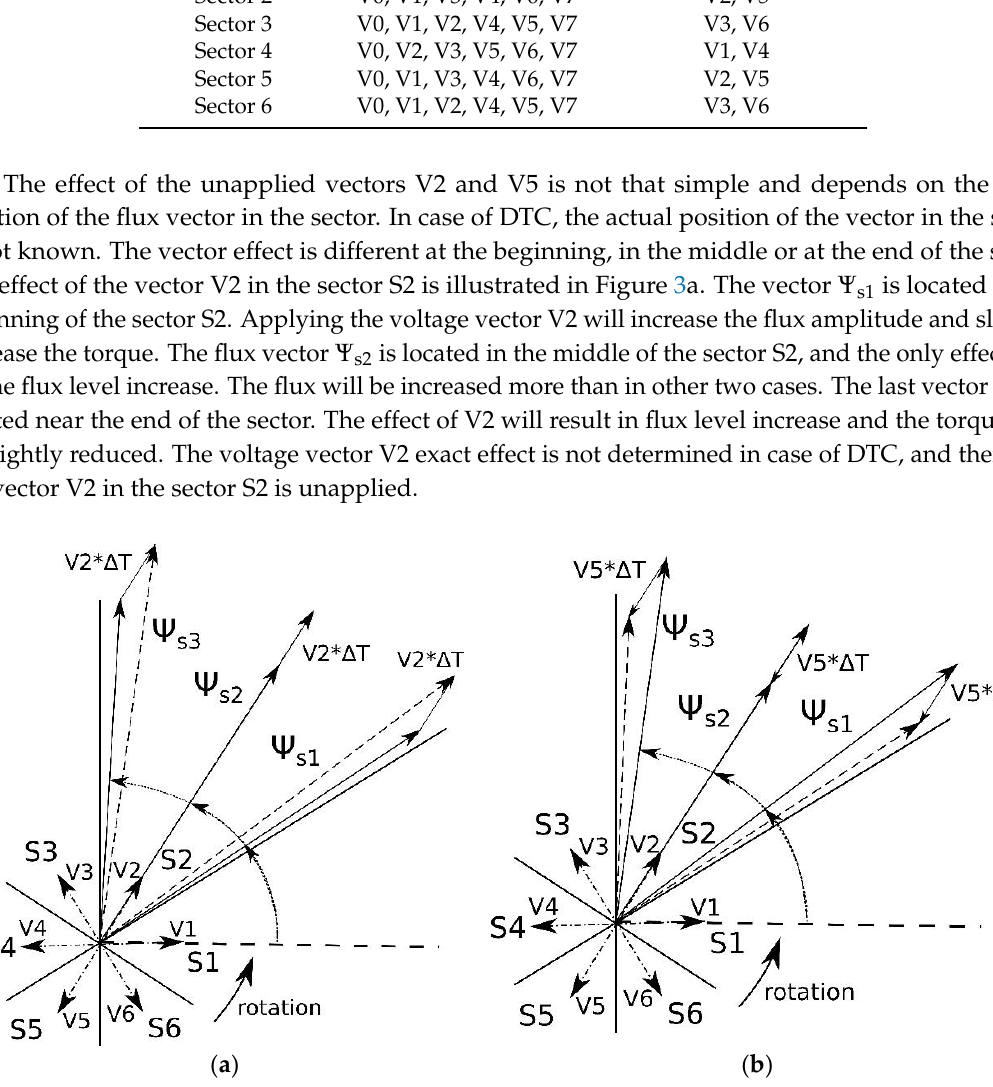
Figure 3. ( a ) Effect of the voltage vector V2 in the flux sector S2. ( b ) Effect of the voltage vector V5